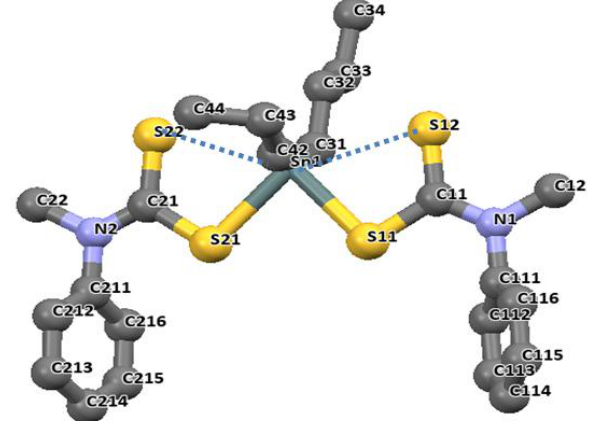
Figure 11. Molecular structure of dibutyltin(IV) complexes of N -methyl- N -phenyldithiocarbamate [(C 4 H 9 ) 2 SnL 2 ]. (For clarity, H atoms were omitted). Redrawn from [86], with permission from Elsevier (Copyright 2018).